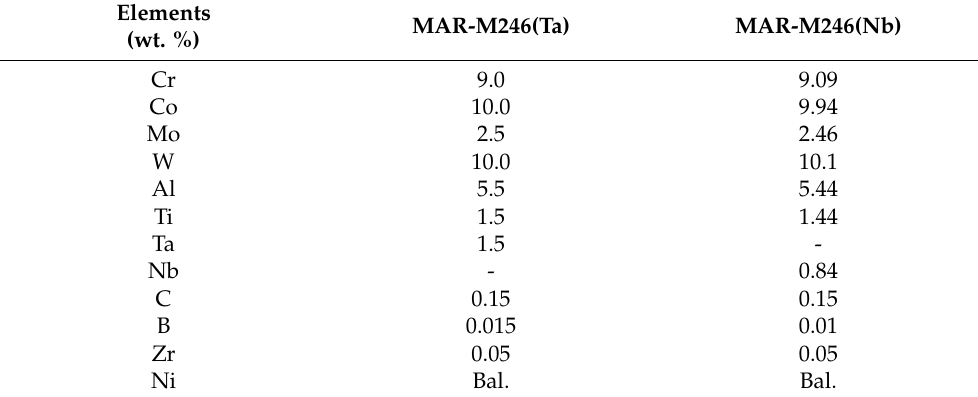
Table 1. Chemical composition in wt. % of MAR-M246(Ta) and MAR-M246(Nb) superalloys.